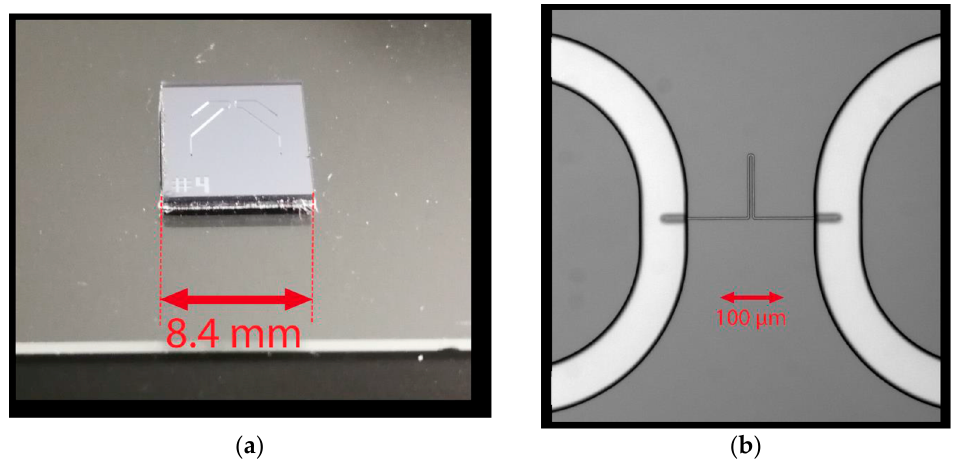
Figure A2. ( a ) Photogrpaph of the detection chip and ( b ) measurement channel.